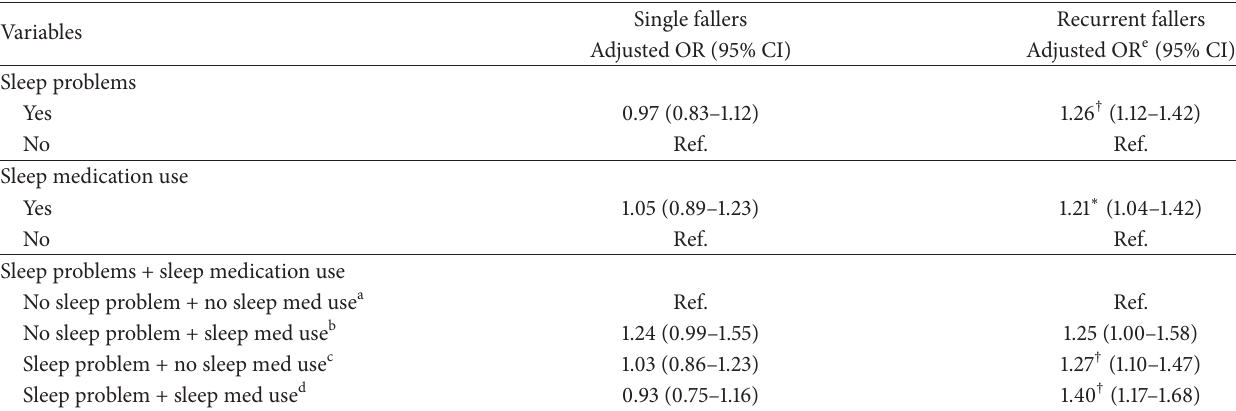
Table 5: Association between sleep problems, sleep medication use, and recurrent falls in community-dwelling older adults in the US, 2010. Variables